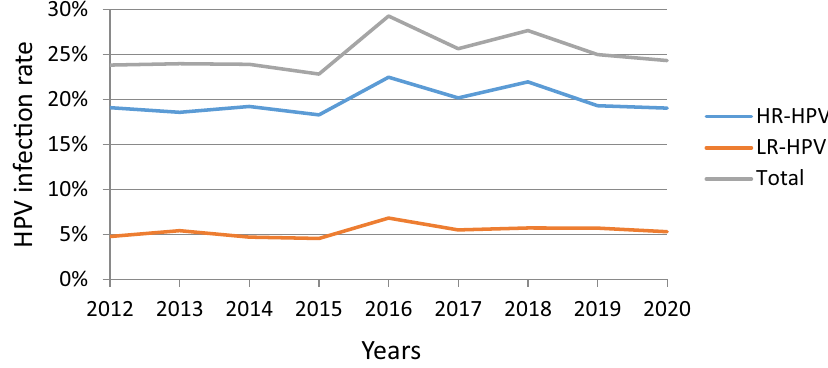
Figure 2. HPV infection rate from 2012 to 2020.